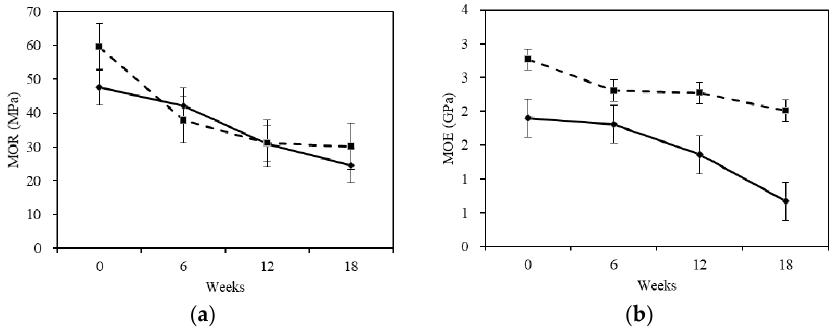
Figure 2. Changes of ( a ) modulus of rupture (MOR) and ( b ) modulus of elongation (MOE) before and after degradation. The continuous and discontinuous lines in the figure caption indicates sapwood and heartwood. The error bar is according to a confidence interval of 95%.